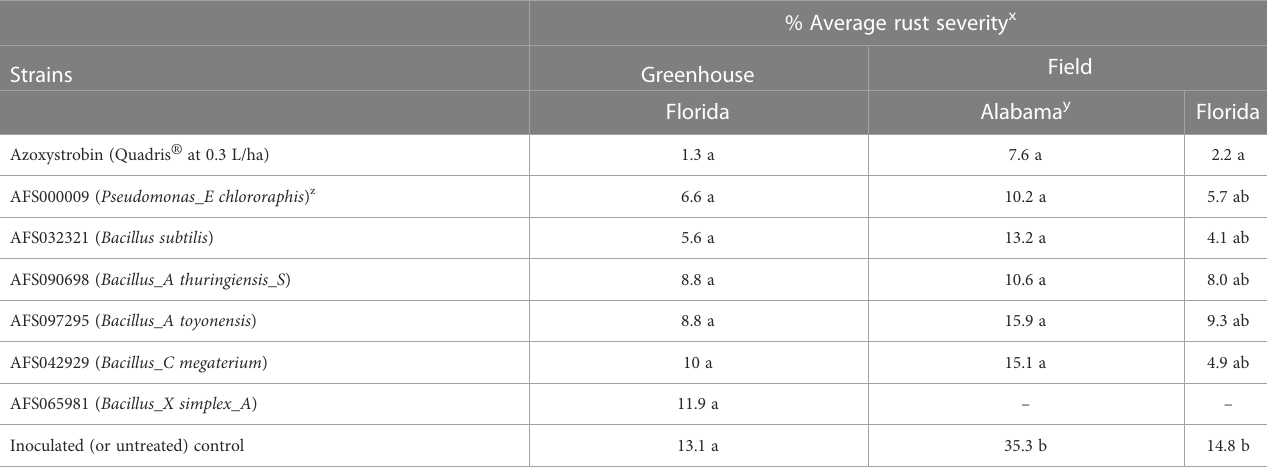
TABLE 2 Mean numbers of percent rust severity for bacterial isolates evaluated for their activity against Phakopsora pachyrhizi in the greenhouse and fi eld trials at North Florida Research and Education Center (NFREC) in Quincy, Florida and in the fi eld trial at the Gulf Coast Research and Extension Center (GCREC) in Fairhope,